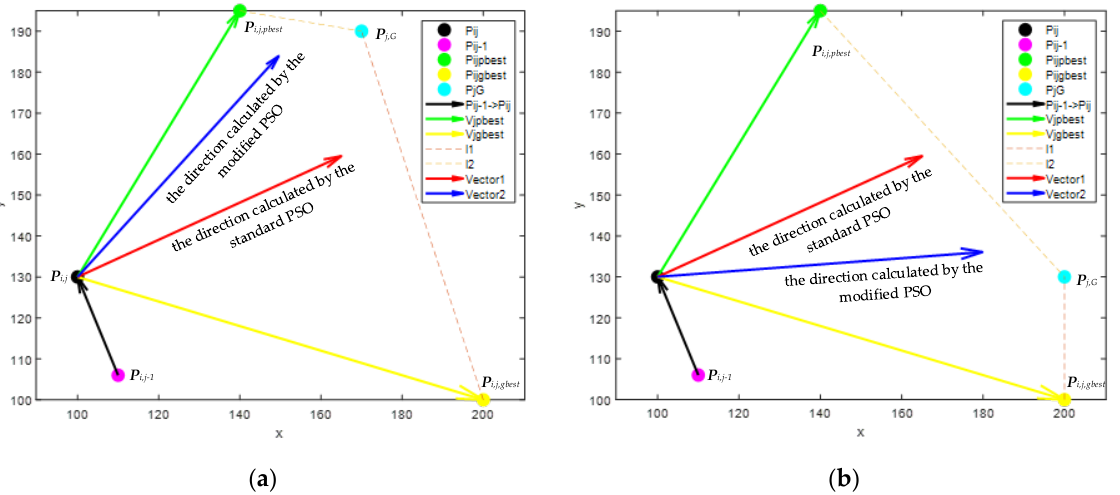
Figure 5. Diagrams of the PSO algorithm’s velocity update method: ( a ) the case where the best position of the particle history is closer to the center of mass of the particle population; ( b ) the case where the best particle of the population is closer to the center of mass of the particle group. Vector1 in the figure is the direction calculated by the standard PSO, and Vector2 is the direction calculated by the modified PSO.